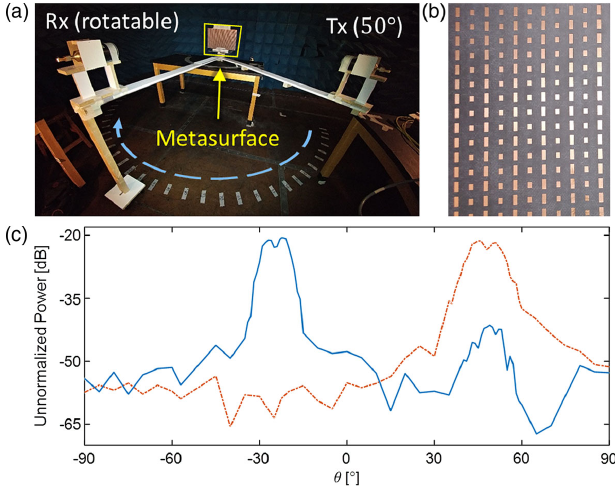
FIG. 6. Experimental demonstration. (a) A photo of the experimental apparatus, showing the transmit (Tx) and receive (Rx) antennas and the test surface platform. (b) A close-up of the BHM. (c) Experimentally measured bistatic RCS for the BHM (solid blue curve) compared against that for a metallic plate of the same size (dashed-dotted red